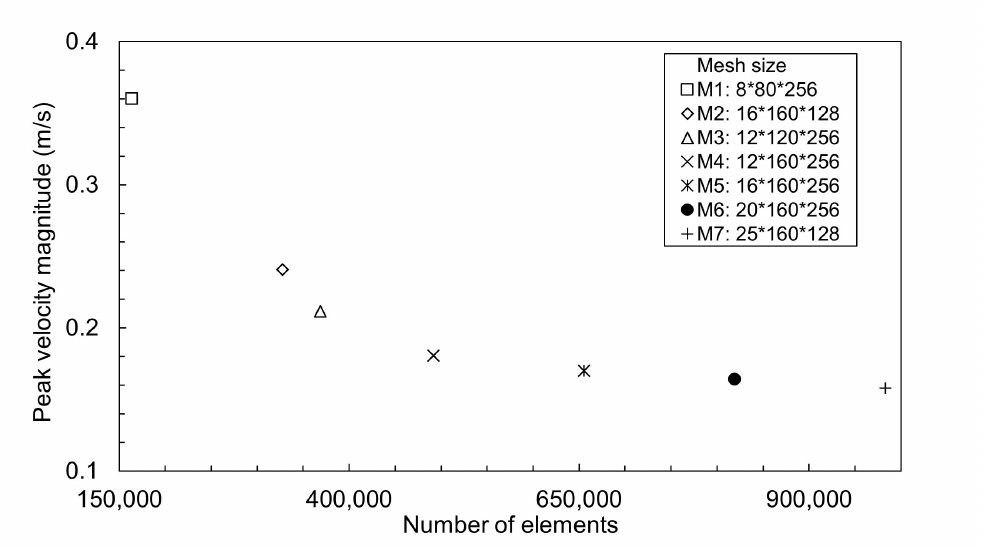
Figure 2. Convergence and mesh independence